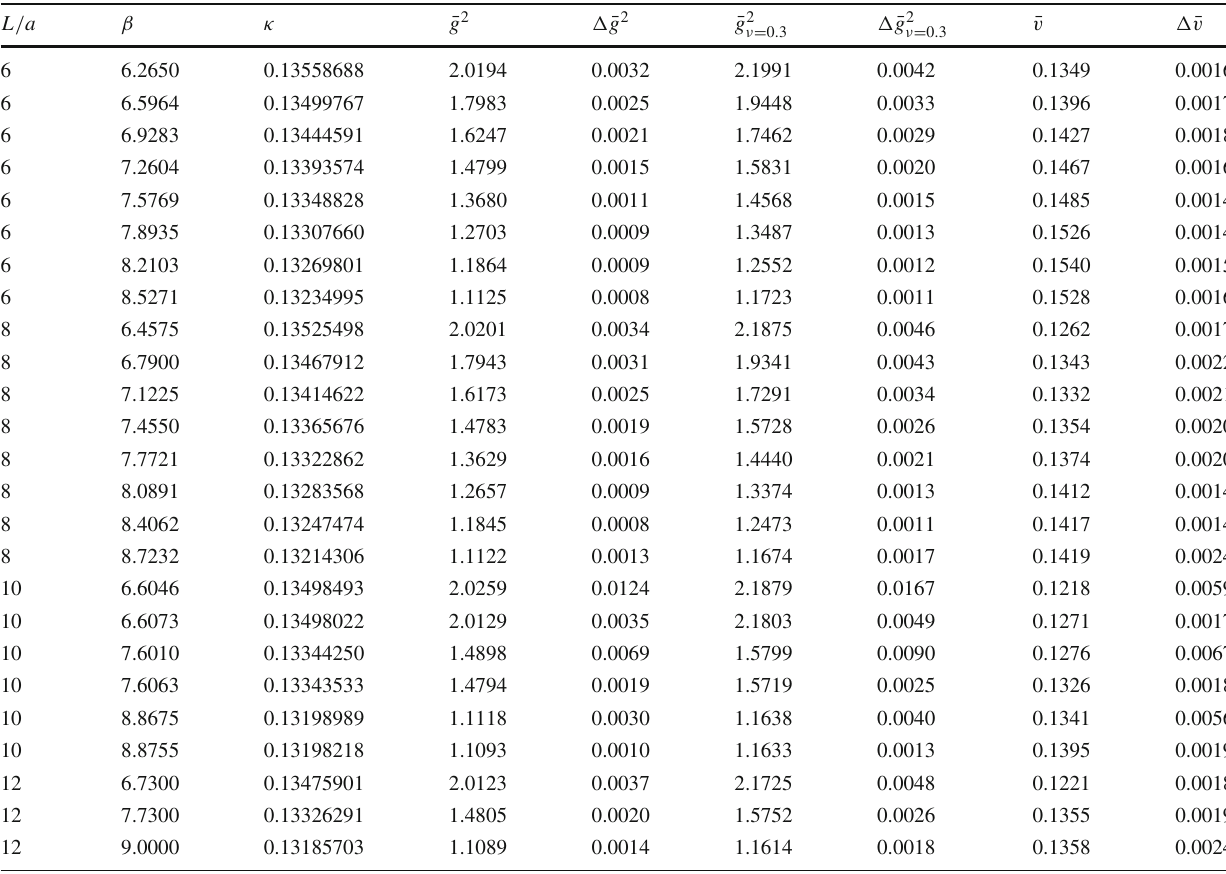
Table 3 Simulation parameters and results on the L -lattices. The hopping parameter κ was tuned such that the PCAC mass m ( L ) , Eq. (3.15), vanishes L /